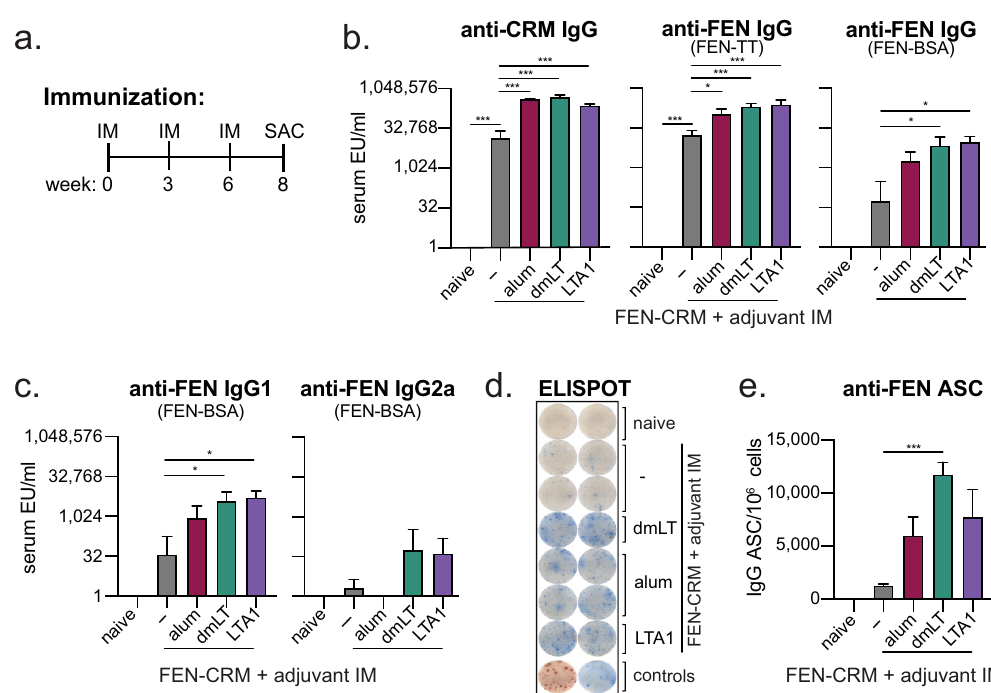
Fig. 3 Immune responses to prime/boost/boost intramuscular FEN-CRM197 immunization are enhanced in magnitude with dmLT and LTA1 adjuvants. Groups of Balb/c mice ( n = 3 – 5) were left naïve or immunized IM with 5 μ g FEN-CRM ± 150 μ g alum, 0.1 μ g dmLT, or 5 μ g LTA1 on weeks 0, 3, and 6. Two-weeks later (week 8) serum and bone-marrow was collected for antibody evaluations. a Schematic of immunization schedule. b Compiled Week 5 and Week 9 serum anti-CRM or anti-FEN (coating antigen indicated) serum IgG. c Compiled EU/ml of indicated serum anti-FEN serum IgG1, or IgG2a ELISAs. d Representative anti-FEN (TT-BSA coated) IgG/IgA ELISPOT images from bone-marrow of week 8 immunized mice. Blue spots indicate IgG and red spots IgA ASCs. e Compiled anti-FEN IgG ASC per 10 6 cells from bone-marrow. Bars at mean + s.e.m. with signi fi cance determined by ANOVA paired with Bonferroni post-hoc test as shown (* P < 0.05, ** P < 0.01, *** P <